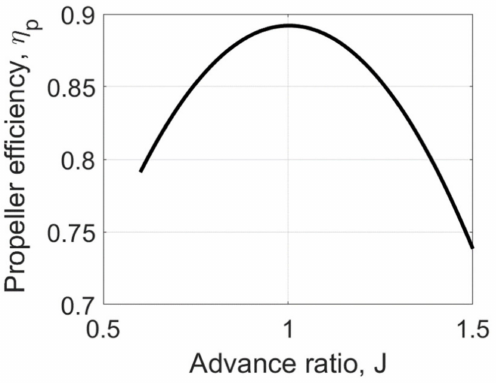
Figure 4. The efficiency of the constant pitch